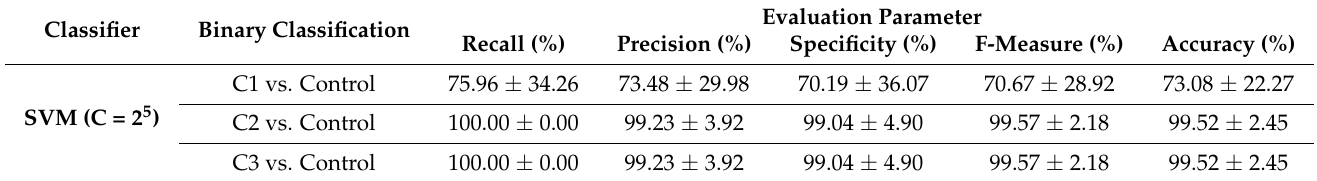
Table 4. Binary classification results considering software metrics labeling.